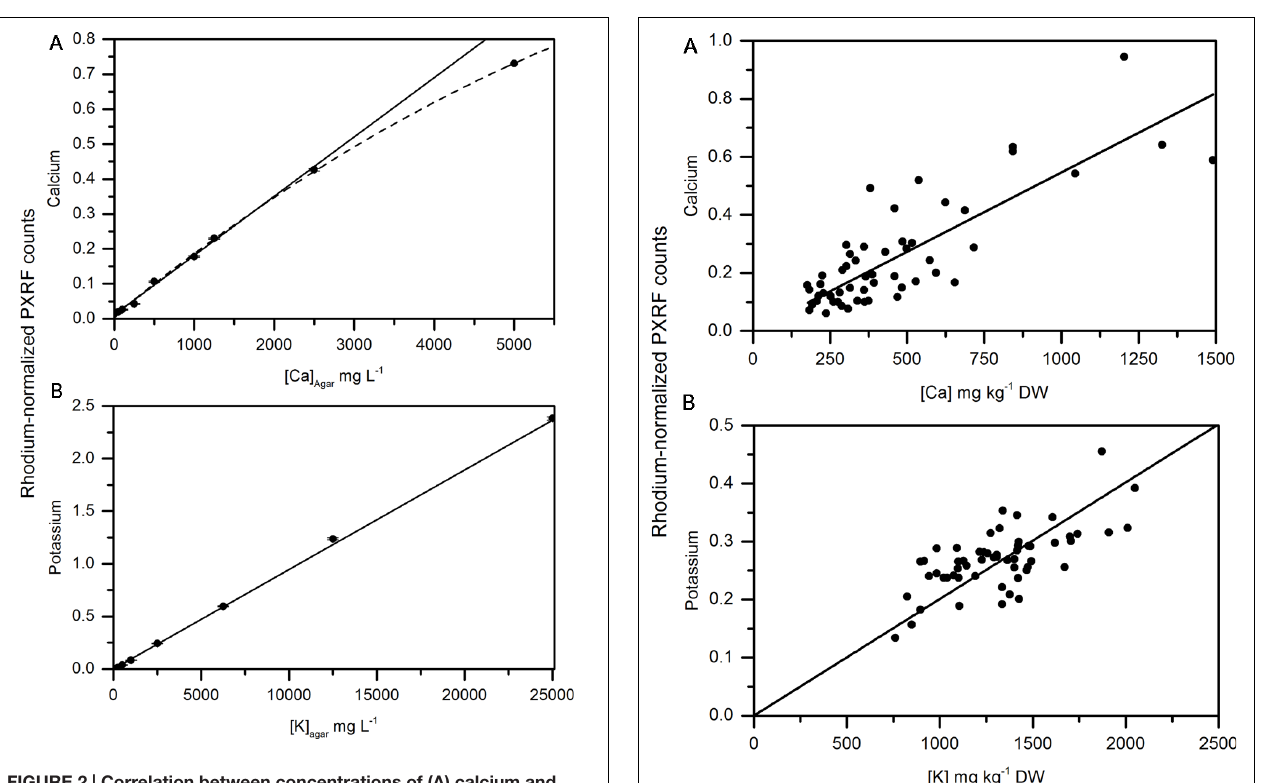
FIGURE 2 | Correlation between concentrations of (A) calcium and (B) potassium in an agar matrix measured using the handheld x-ray fluorometer. The solid line represents the linear fit of calcium and potassium concentrations in the agar up to 2500 and 12,500 mg L − 1 , respectively. The dashed line represents the non-linear fit of agar disks containing calcium up to 5000 mg L − 1 .